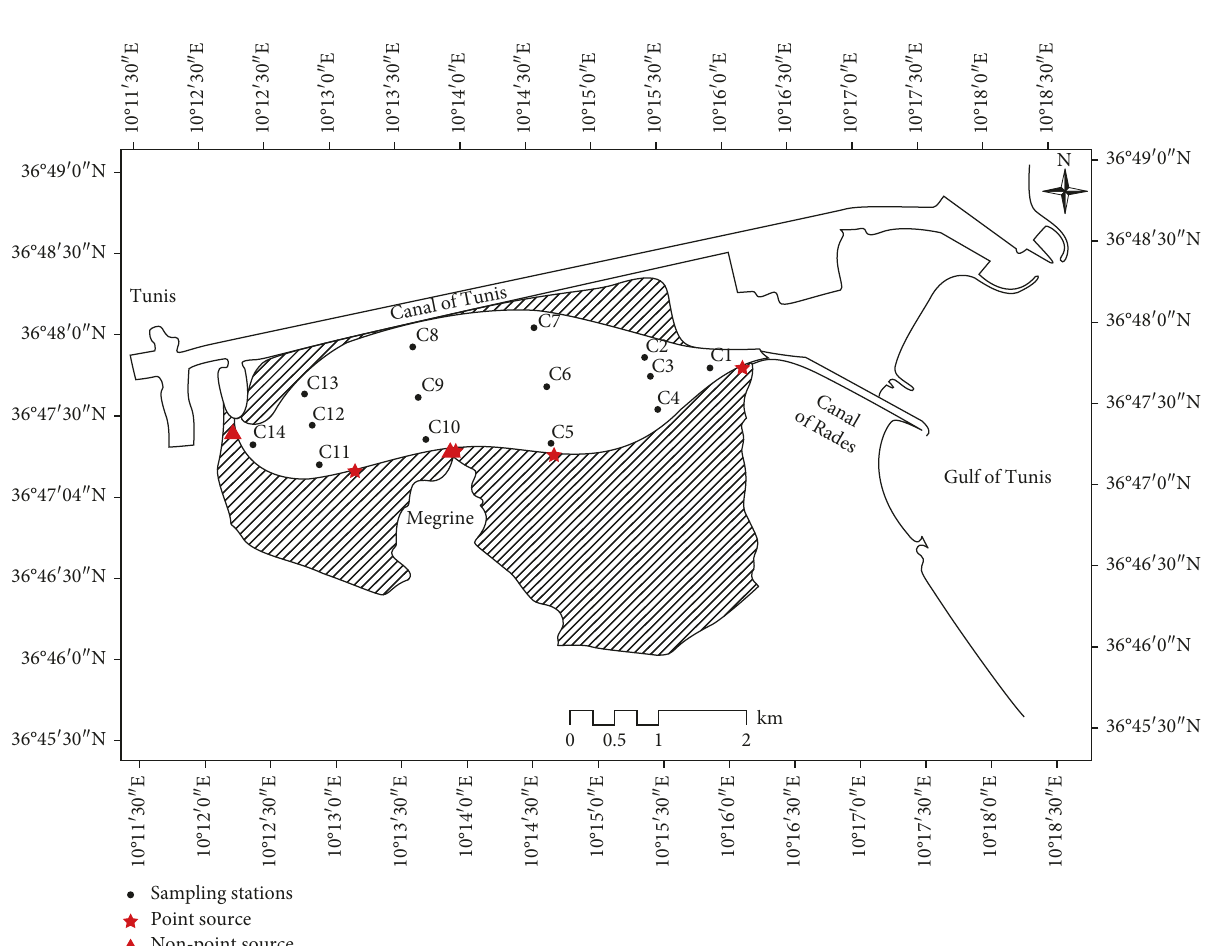
Figure 3: Map showing the location of sampling